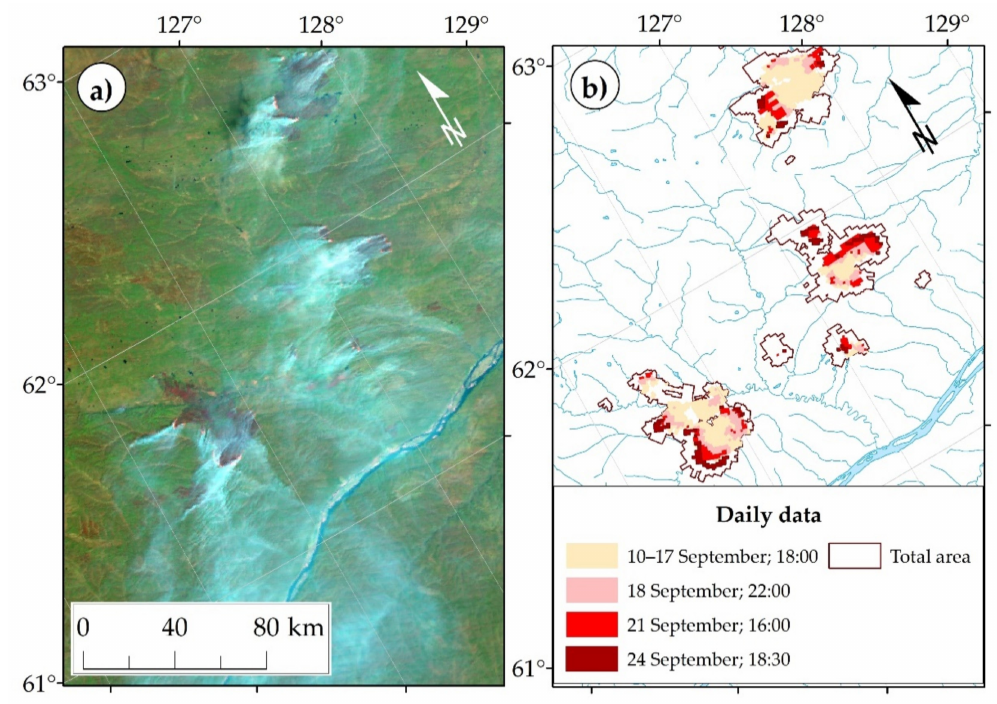
Figure 3. Active burning in Siberia in September of 2020: active wildfires and smoke plumes on Terra/MODIS imagery on 24 September ( a ) and daily records from wildfire database of active burning detected from 10–24 September 2020 ( b